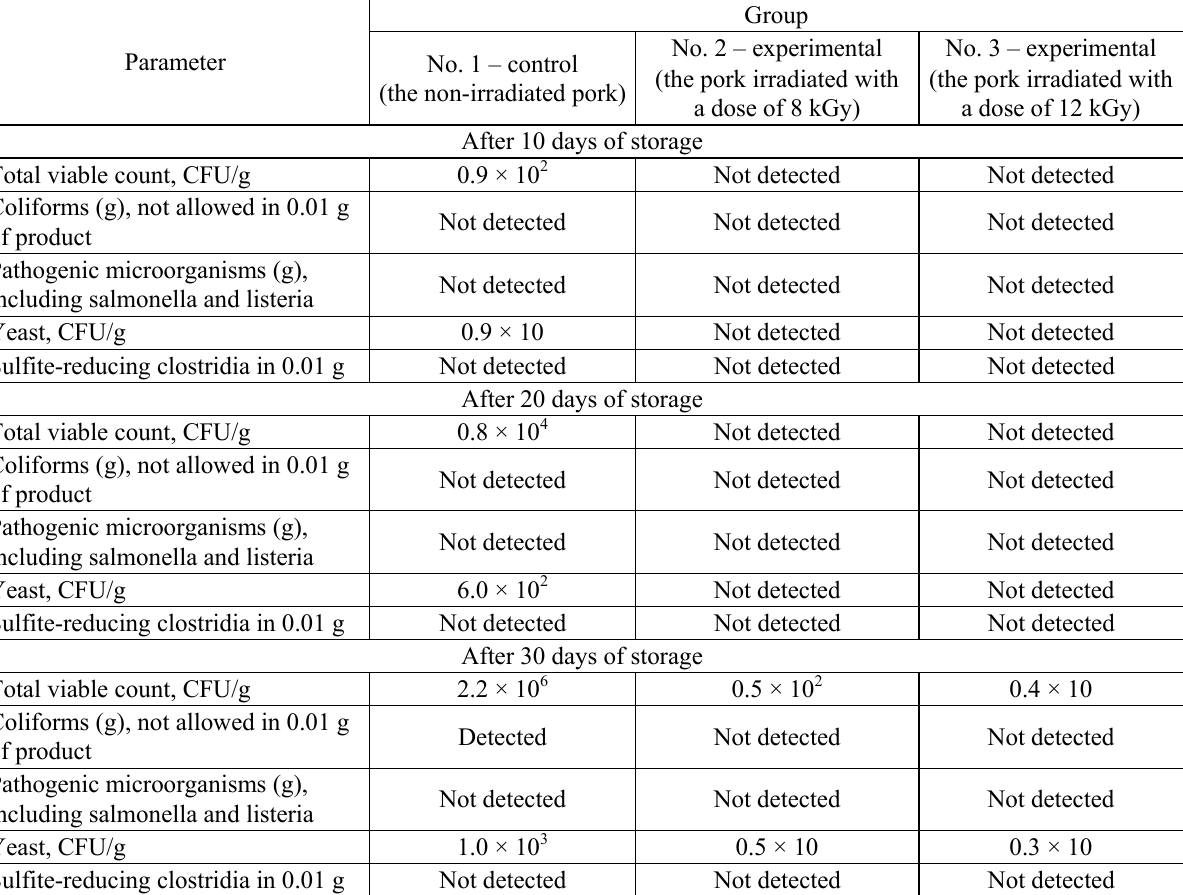
Table 1. Microbiological indicators of the control and experimental samples of the refrigerated pork neck on the bone packed using MAP during storage (n =